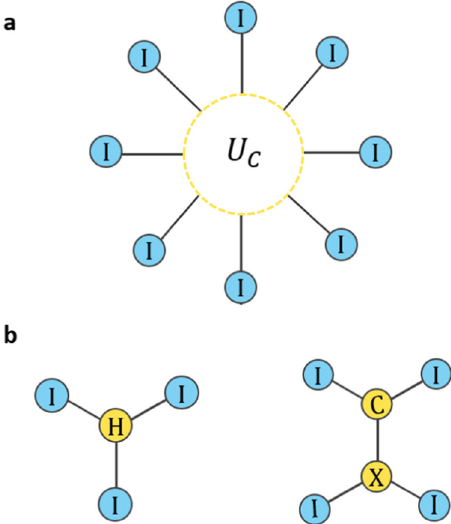
Fig. 3 Applying gates on star graphs. a A star graph with undriven qubits on the boundary and a driven subset of one or more qubits in the centre. Each undriven qubit must be connected to at least one driven qubit. By utilising optimal control on the driven subset it is possible to apply a unitary of the form U C (cid:5) I B where U C is a target unitary on the central driven subset, and I B (cid:4) I (cid:5) I (cid:5) (cid:7)(cid:7)(cid:7) (cid:5) I is the identity in the Hilbert space of the undriven qubits on the boundary (see text). b Examples of applying a Hamadard gate on the four- qubit block and CNOT (CX) gate on the six-qubit block of Fig. 2. In both cases the identity operators are applied on all undriven P H ð t Þ ¼ H j ð t Þ where L is the driven subarray and j 2L